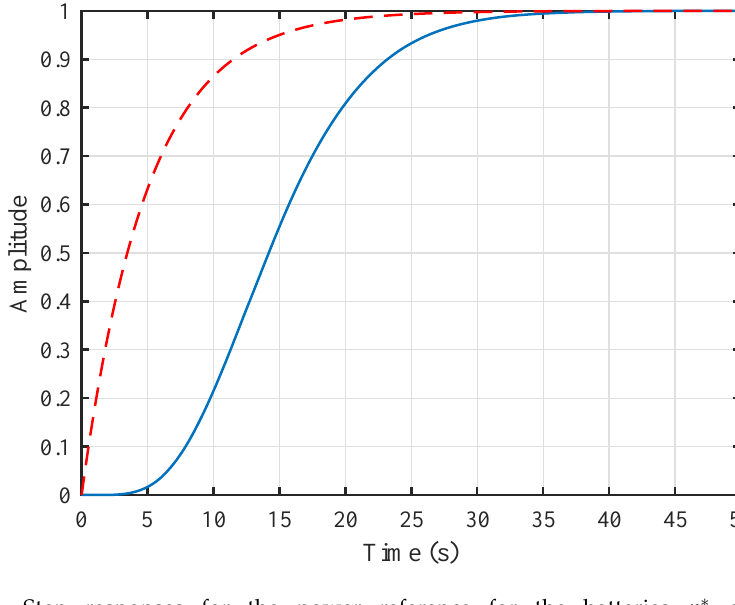
obtained with b